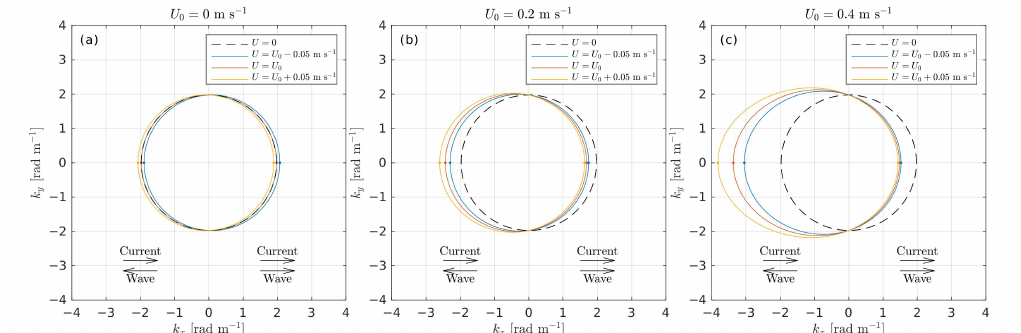
Figure 7. Wave dispersion curves illustrating sea surface current (SSC) reconstruction error at different SSC magnitudes: ( a ) U = 0 m s − 1 ; ( b ) U = 0.20 m s − 1 ; and ( c ) U = 0.40 m s − 1 . The SSC, directed along the positive x -axis, is varied within ± 0.05 m s − 1 range. The waves with k x > 0 ( k x < 0) are aligned with (opposite to) the SSC. The wave frequency is fixed at f = 0.7